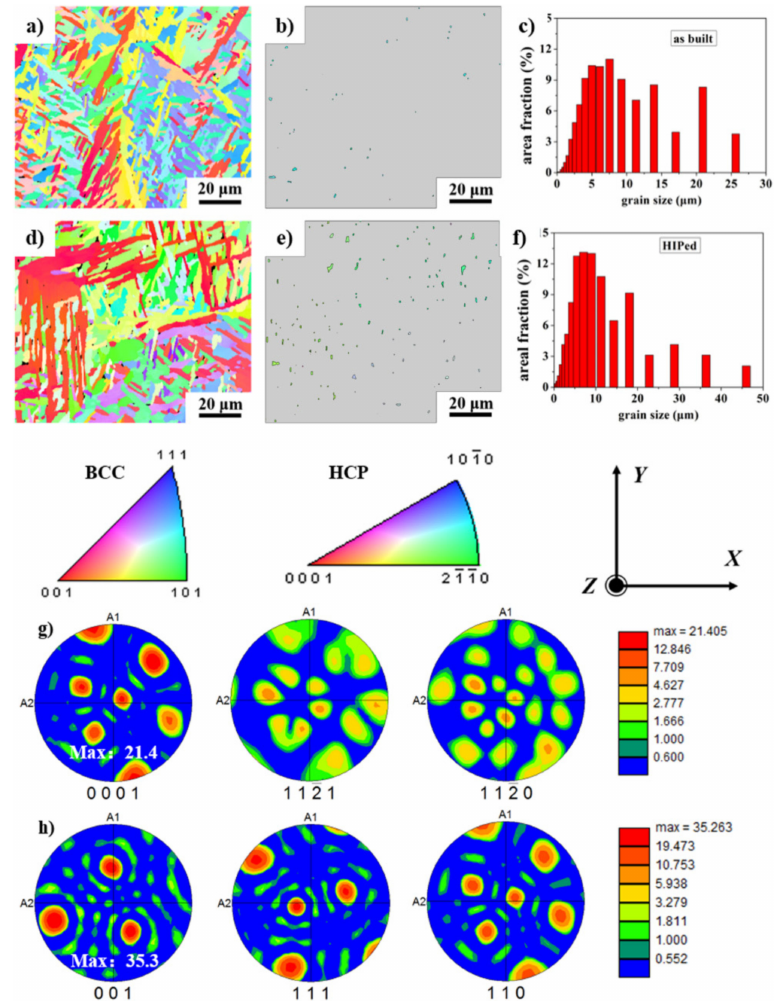
Figure 5. Electron backscattered di ff raction (EBSD) analysis of as-built and HIPed samples: ( a ) grain orientation mapping of as-built sample on the transversal section; ( b ) phase indexing of as-built sample (black represents α phase); ( c ) grain size distribution of as-built sample; ( d ) IPF of HIPed sample; ( e ) phase indexing of HIPed sample; ( f ) grain size distribution of HIPed sample; ( g ) pole figure of α phase; ( h ) pole figure of β